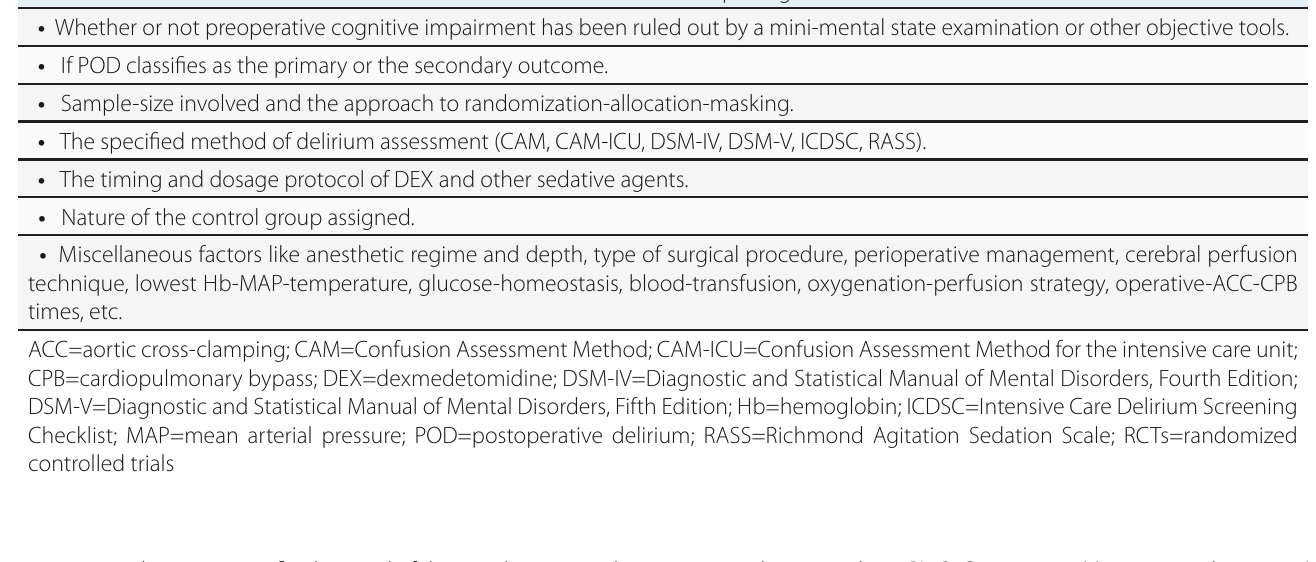
Table 2. Intricacies of the DEX-delirium RCTs to be considered while interpreting the results [9,14-17]